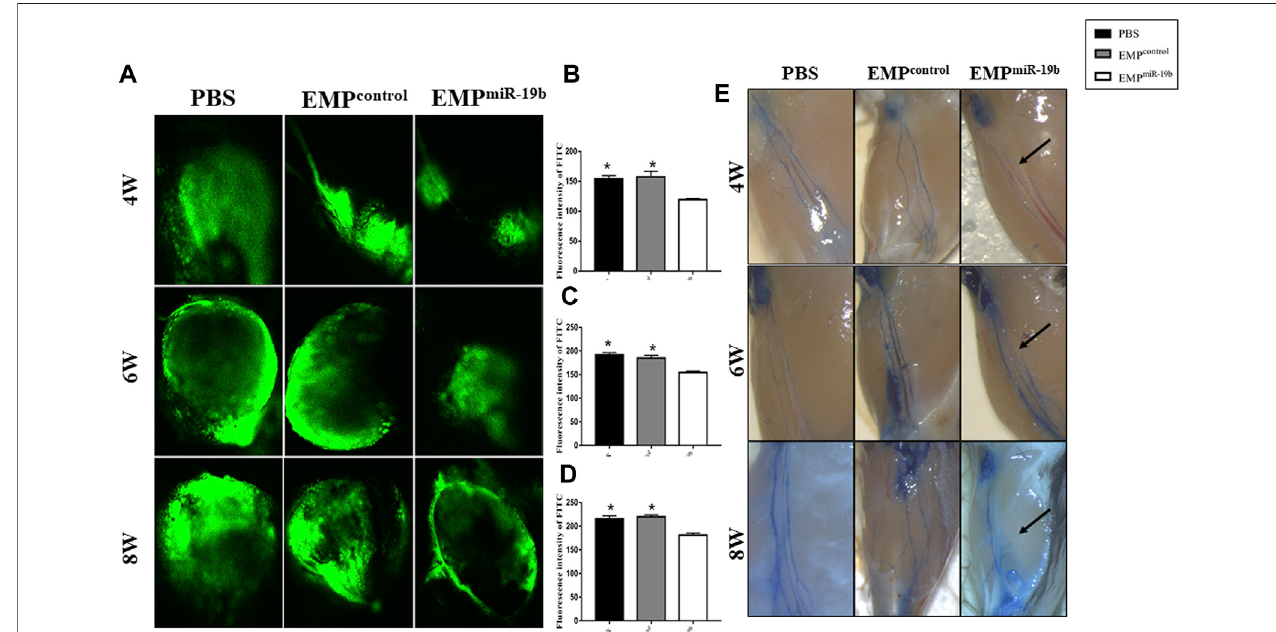
FIGURE5| EMP miR-19b induce lymphatic system dysfunction inApoE -/- mice. (A) Representativeconfocal images ofFITC fl uorescence intensityin popliteal lymph nodesofhigh-fatdiet-fedApoE -/- miceintravenouslyinjectedwithPBS,EMP control ,orEMP miR-19b for4,6,or8 weeks. (B – D) Quantitativeanalysisoftheresultsshownin (A) . * p < 0.05 compared with EMP miR-19b group, n = 5 – 6 per group. (E) Representative images of Evans blue staining of lymphatic vessels in legs from high-fat diet-fed ApoE -/- mice intravenously injected with PBS, EMP control , or EMP miR-19b for 4, 6, or 8